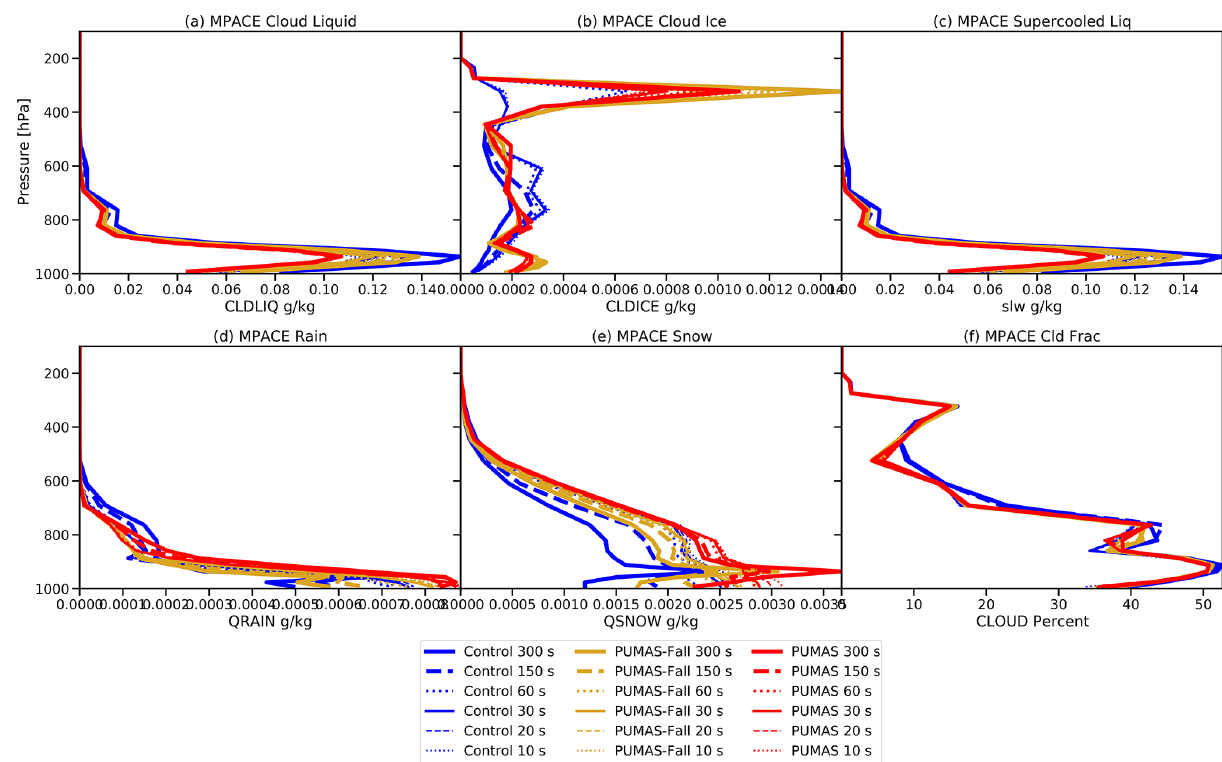
Figure 5. As in Fig. 4 except for the M-PACE case.